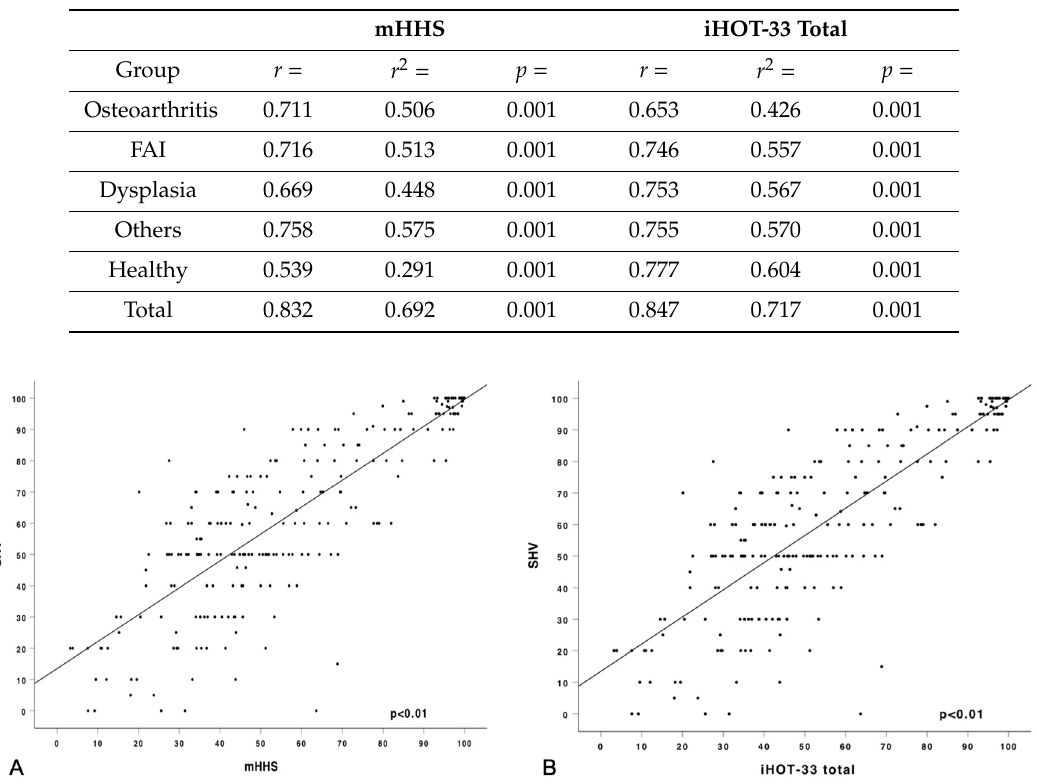
Table 2. Correlation coe ffi cients ( r ) and r 2 of the subjective hip value (SHV) with the modified Harris hip score (mHHS) and the International Hip Outcome Tool (iHOT-33).